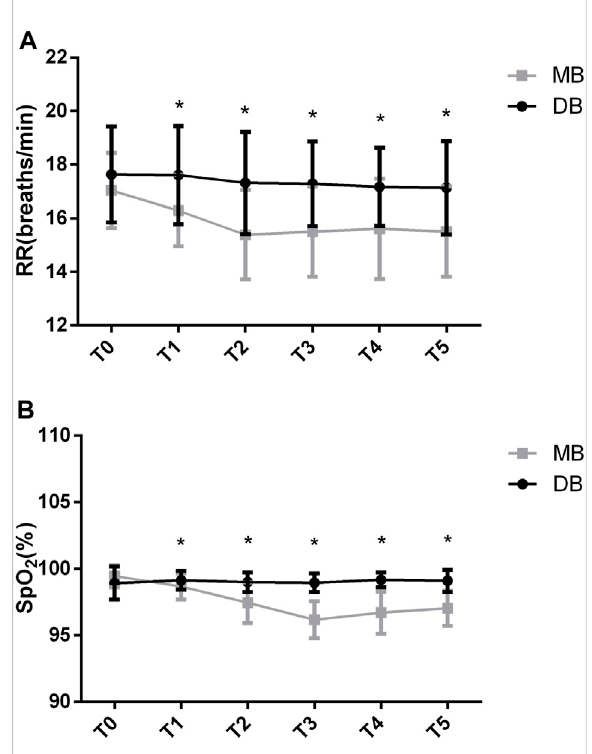
FIGURE 3 RR and SPO 2 values of the two groups. Abbreviation: DB, dexmedetomidine- butorphanol; MB, midazolam-butorphanol; T0: baseline, T1: beginning, T2: 5 min, T3: 10 min, T4: 15 min, T5: 20 min. * p < 0.05 compared with the DB